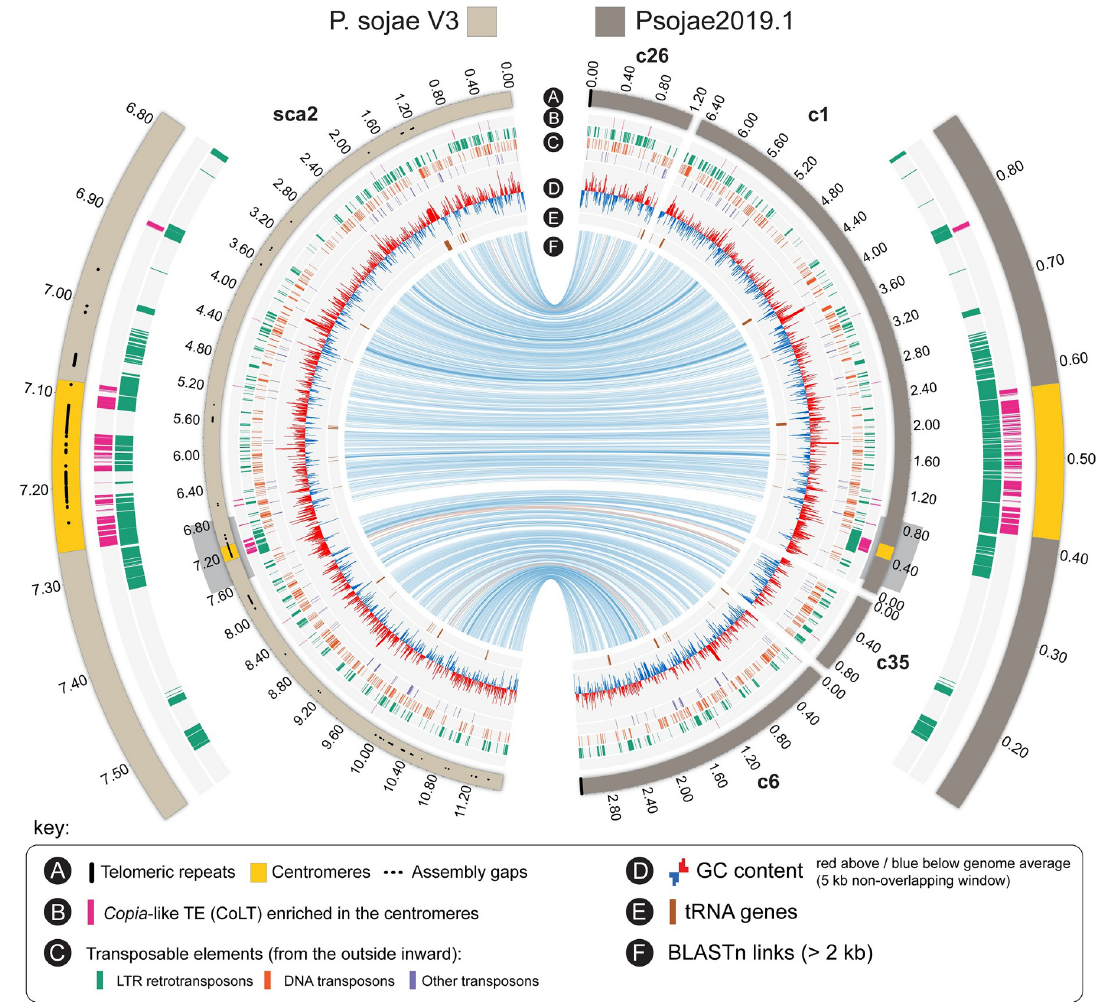
Fig 3. A representative Circos visualization comparing a centromere-containing scaffold in Sanger V3 (Scaffold 2) with its corresponding contigs in the Psojae2019.1 assembly. For the inner circle, track A illustrates assembled contigs (in Psojae2019.1) or scaffold (in P. sojae V3) that are color coded as shown at the top. The locations of centromeres (CENP-A binding regions) are highlighted in yellow. Tracks B-E show the location of other genomic features as given in the key on the bottom. Blue and orange lines in track F link regions with collinearity extending over 2 kb, with orange lines corresponding to inversions. Grey box-shaded centromere- containing regions are magnified for detailed visualization (the two outer